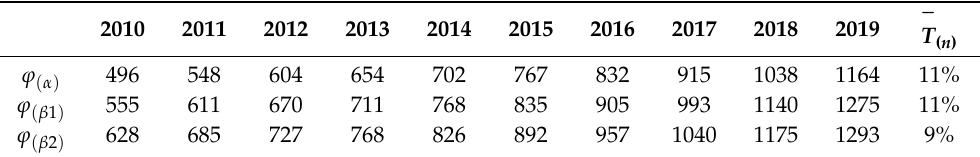
Table 4. Approximation of GDP (per capita) in the assessed group and control groups, Polish currency (PLN).